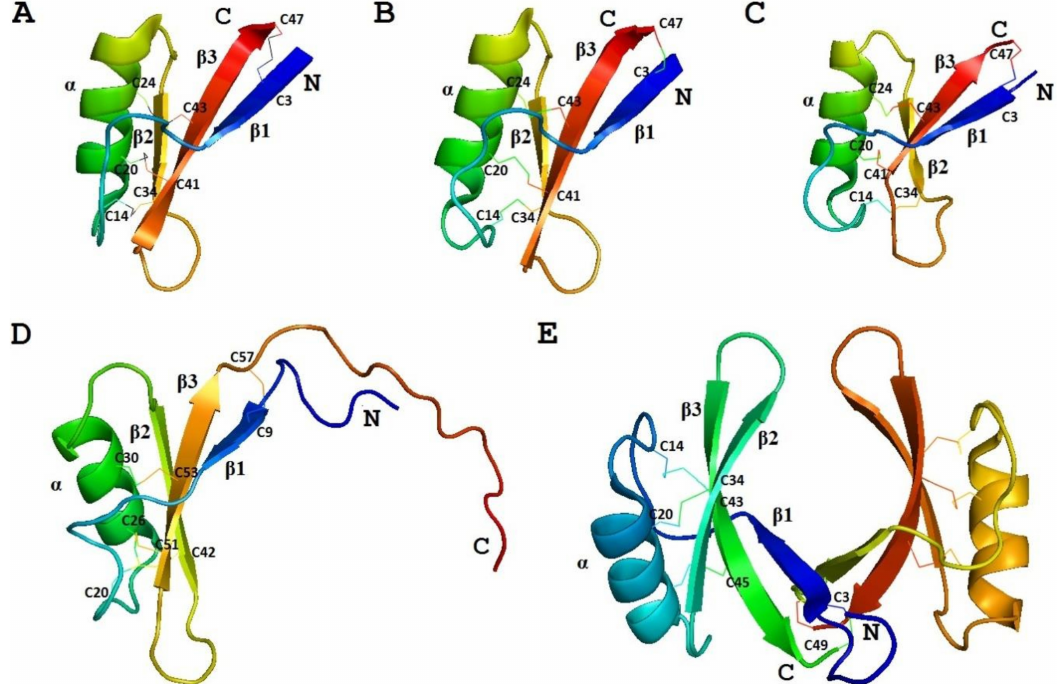
Figure 2. The3Dstructureofdefensins: ( A )wheat γ 1 -purothionin(PDB1GPS),( B )barley γ -hordothionin (PDB1GPT),( C )maizeZmD32(PDB6DMZ),( D )sugarcaneSd5(PDB2KSK),( E )riceOsAFP1(PDB6LCQ). Disulfide bonds are shown by thin lines. The N-and C-termini are indicated by N and C, respectively. Secondary structure elements are denoted by α for α -helix and β for β